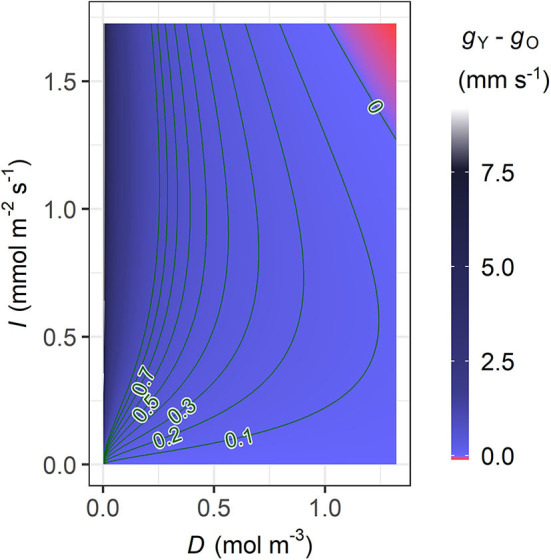
Contour plot of the difference in stomatal conductance between the young and old sample trees (gY−gO, mm s−1) modelled with the maxima a posteriori (MAP) estimates of λ, ι, and γ (Table 3A), in relation to vapour deficit (D) and photosynthetic photon flux density (I). The colour legend of gY−gO (right) ranges up to the g value that allowed the maximum sap flow density during the measurement period, and the higher values are coloured in grey. The lowest value in the red area is −9.54 × 10−2 mm s−1.